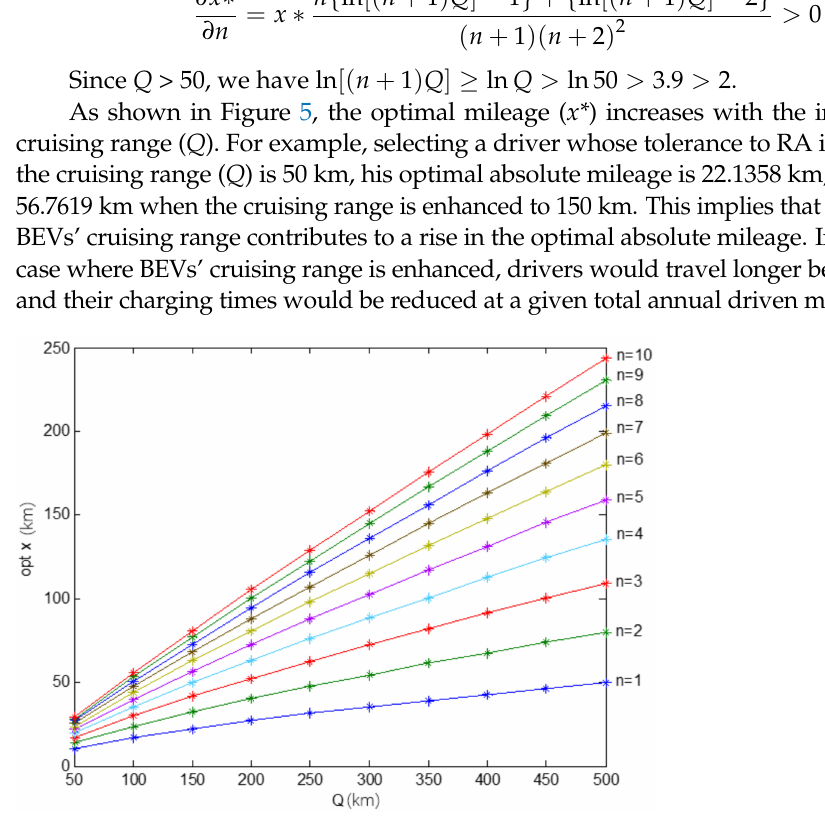
Figure 5. The optimal x under different cruising range